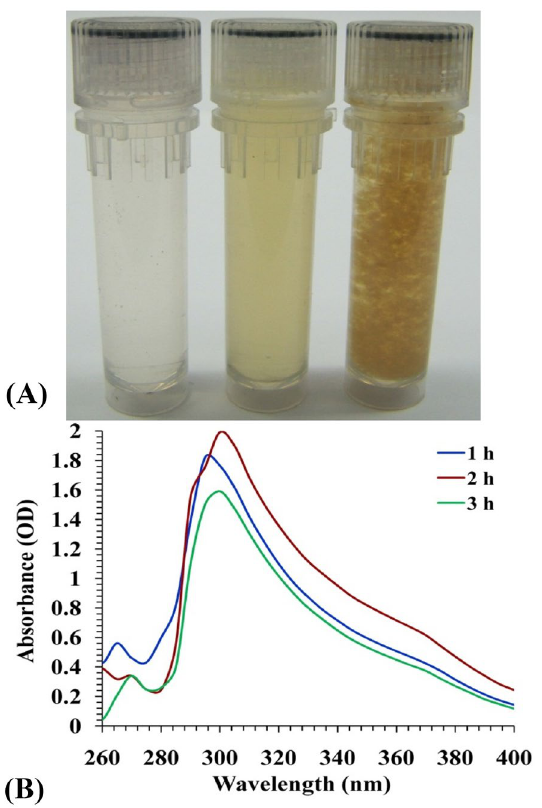
Figure 1. (A) Three vials contain (1, Chitosan solution; 2, Eucalyptus globulus Labill leaves extract; 3, biosynthesized chitosan nanoparticles). (B) UV–vis spectrum of chitosan nanoparticles biosynthesised using Eucalyptus globulus Labill leaves